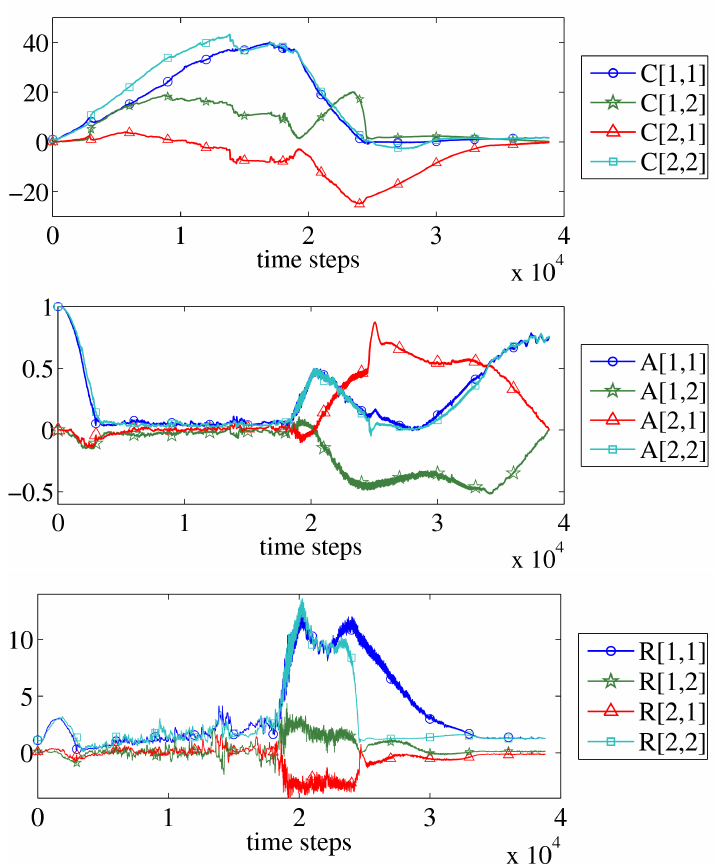
Figure 3. Parameters during the experiment. Top: Matrix c of controller parameters show- ing the increase of sensitivity, in the first half of the diagram, while in the second half when the rotational whole-body motion sets in the reaction strength is turned down since there is a definite response of the body to the controller actions even with smaller parameter val- ues. Center: Matrix a of model parameters shows the correlation between sensor and motor values. At the beginning there is a decrease from the initial values to the ones representing the weak reaction of the head element to the controller outputs. After step 18000 when the rotational mode sets in the diagonal elements increase since there is a definite response of the body to the controller actions. Bottom: The response matrix R of the system shows a steep rise when the rotational mode emerges. After a stable period the response strength decreases, showing a SO(2)-like form at the end of the experiment reflecting the systems rotational mode of lower frequency. It is seen that the response strength is self-regulating to a slightly supercritical value if the system gives valuable